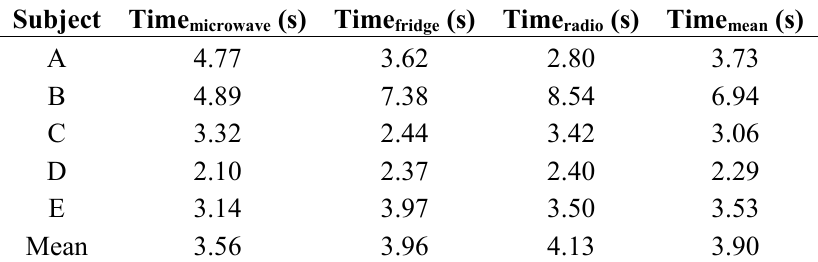
Table 5. Selection time using eye tracker.